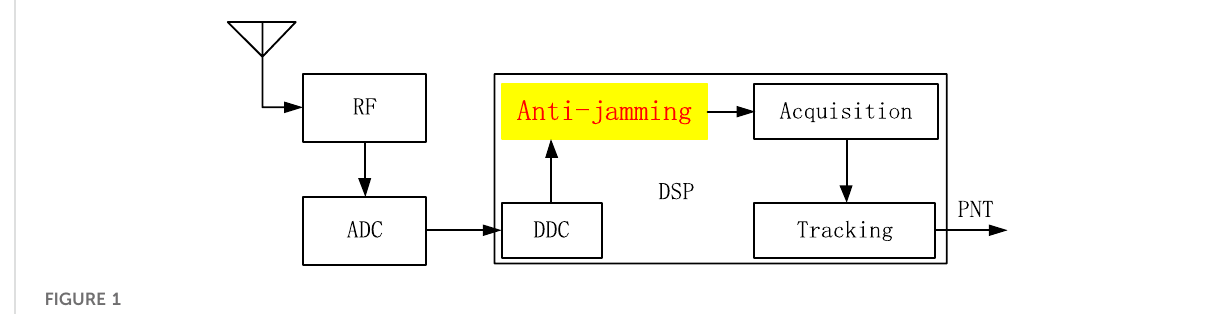
FIGURE 1 Satellite navigation receiver architecture.